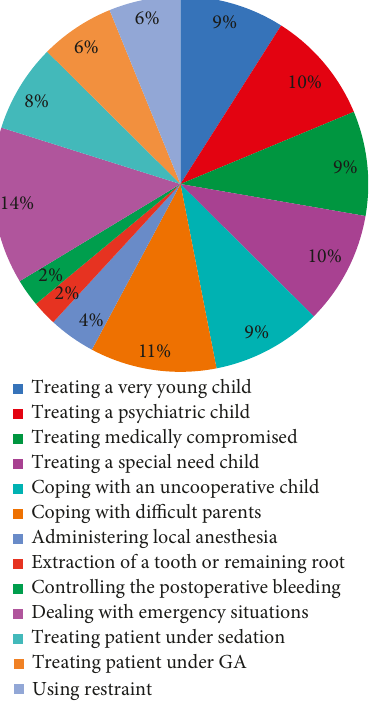
Figure 6: Level of anxiety during various clinical